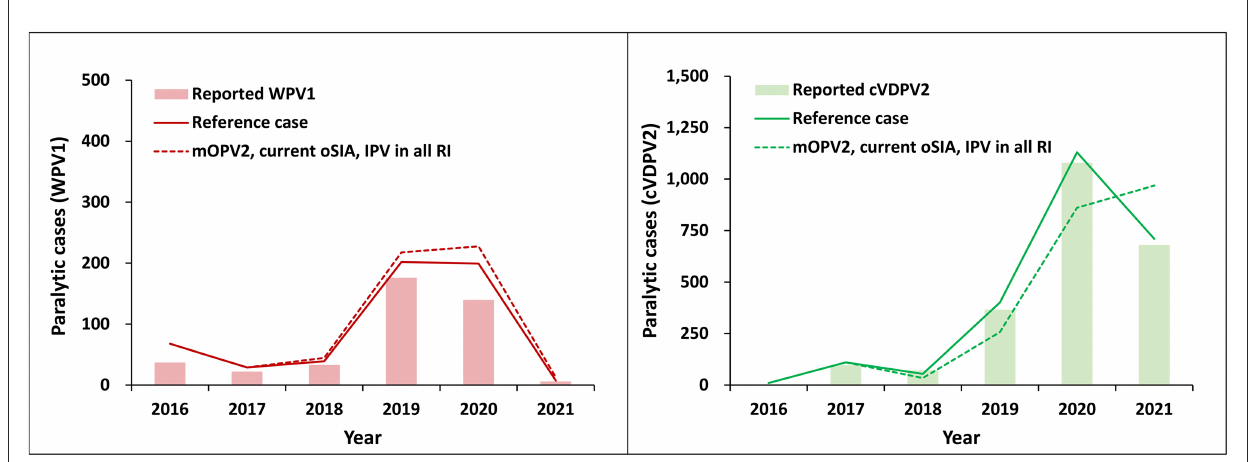
FIGURE1 Similarity between the expected global number of paralytic WPV1 (left panel) and cVDPV2 (right panel) cases by year for 100 stochastic iterations of the “mOPV2, current oSIA” scenario for 2016–2021 (dashed lines) compared to the deterministic reference case (RC, solid lines). In all modeled scenarios, IPV is used in RI in all countries as a prerequisite to OPV cessation. The actual number of reported cases are shown in solid bars for